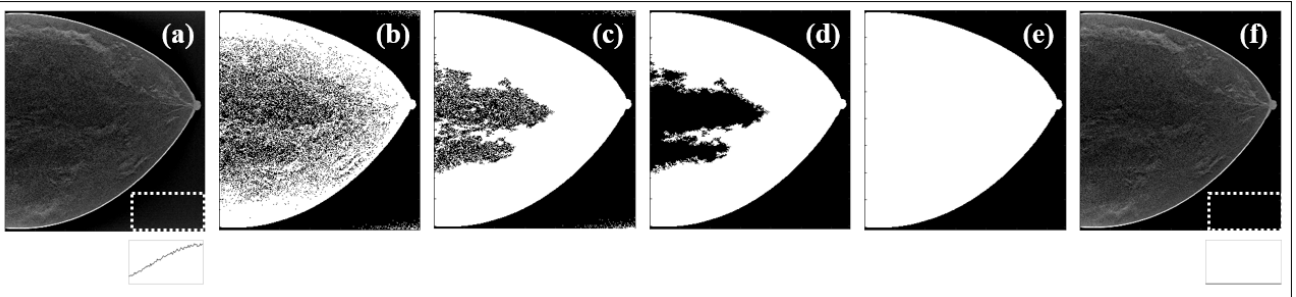
Figure 4. ( a ) Data with contaminated BG; ( b ) first binary image; ( c ) filled binary image; ( d ) largest object extracted from binary image; ( e ) result from region growing; ( f ) final image with BG corrected after binary mask from ( e ) applied to ( a ).